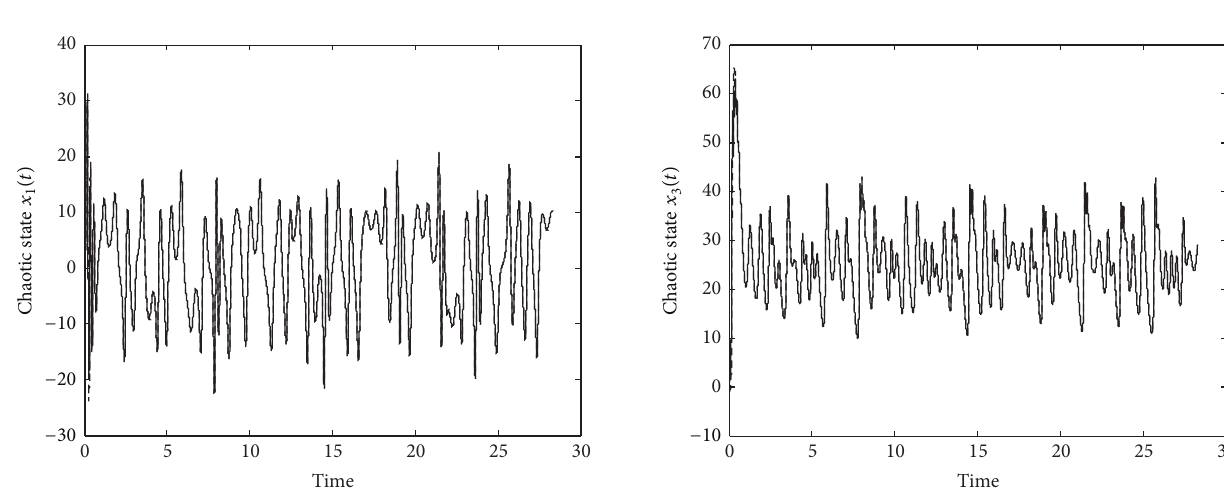
Figure 5: Actual chaotic state 𝑥 3 (dashed line) and its estimate ̂𝑥 3 (solid line).